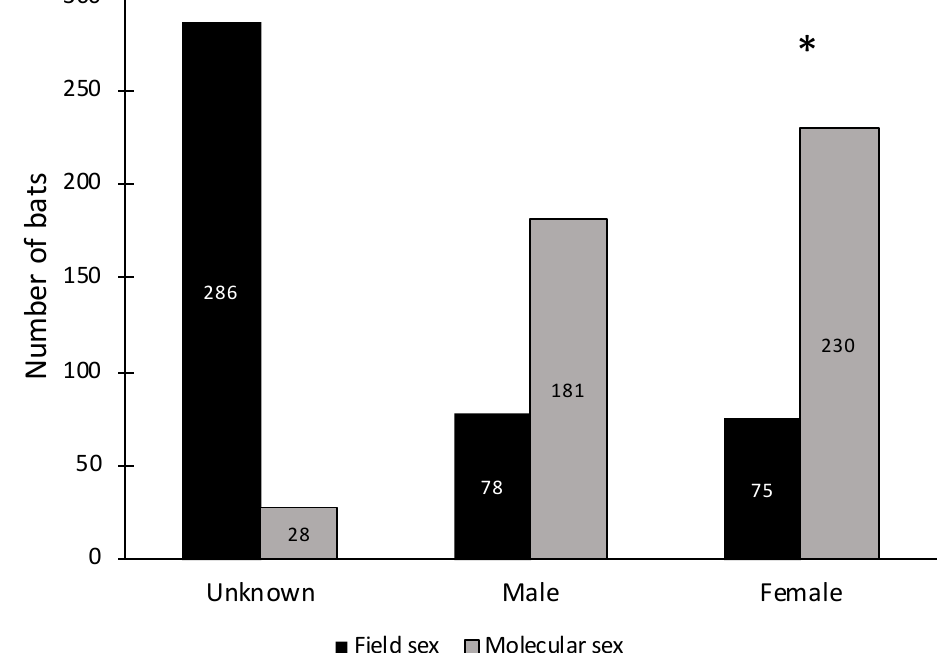
Figure 3. Number of individual bats from all species combined that were assigned the sex of unknown, male, or female based on external morphology in the field or by using molecular methods ( n = 439). The star above the female category indicates a significant deviation from a 50:50 sex ratio (Fisher’s exact test: p = 0.016).